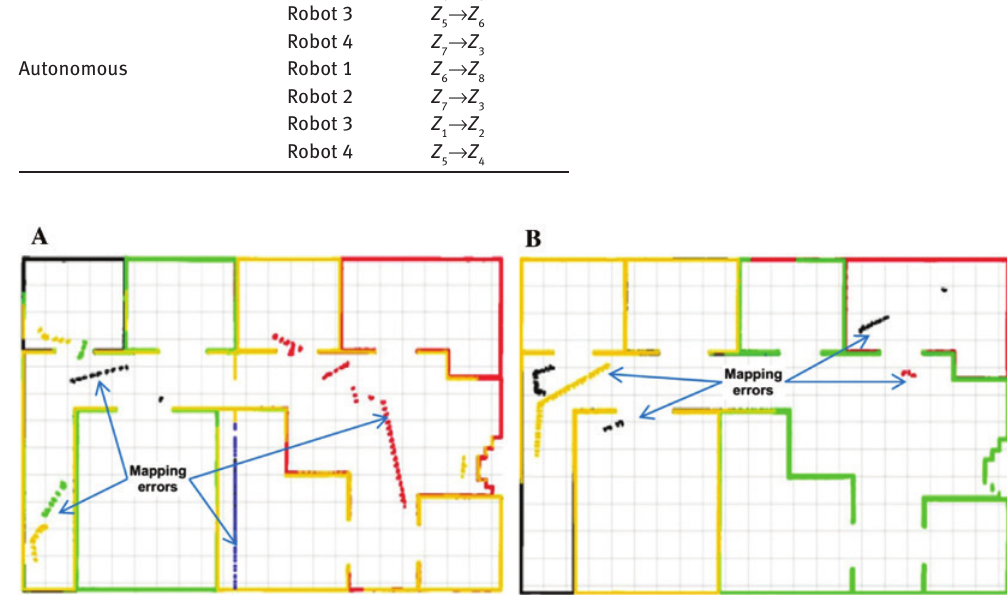
Figure 9: Generated Global Maps for the Scenario with Four Robots: (A) Generated Map for the Random Approach and (B) Gener- ated Map for the Autonomous Approach.